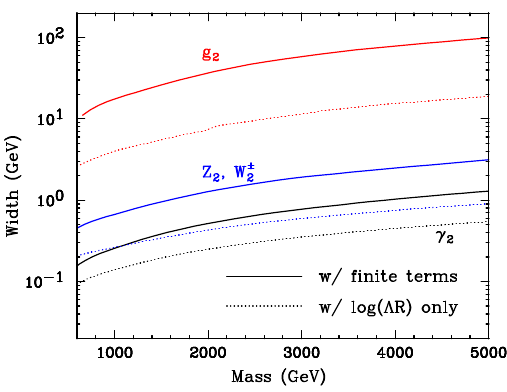
Figure 15 . The decay width of level-2 gauge bosons as a function of R (cid:0) 1 for (cid:3) R = 20. Solid curves include (cid:12)nite corrections, while dotted curves are old results.